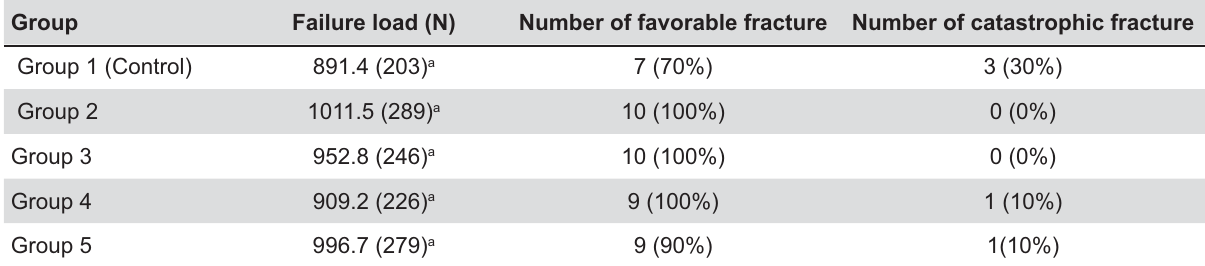
(cid:2)(cid:3)(cid:4)(cid:3)(cid:5)(cid:6)(cid:7)(cid:8)(cid:9)(cid:10)(cid:11)(cid:12)(cid:7)(cid:9)(cid:13)(cid:7)(cid:3)(cid:11)(cid:14)(cid:8)(cid:5)(cid:12)(cid:14)(cid:14)(cid:12)(cid:7)(cid:8)(cid:3)(cid:15)(cid:16)(cid:3)(cid:13)(cid:6)(cid:14)(cid:12)(cid:9)(cid:8)(cid:15)(cid:17)(cid:8)(cid:9)(cid:3)(cid:18)(cid:15)(cid:3)(cid:19)(cid:13)(cid:6)(cid:15)(cid:14)(cid:8)(cid:16)(cid:3)(cid:20)(cid:20)(cid:12)(cid:7)(cid:12)(cid:15)(cid:13)(cid:12)(cid:8)(cid:21)(cid:12)(cid:14)(cid:22)(cid:12)(cid:12)(cid:15)(cid:8)(cid:16)(cid:3)(cid:20)(cid:20)(cid:12)(cid:7)(cid:12)(cid:15)(cid:14)(cid:8)(cid:14)(cid:12)(cid:9)(cid:14)(cid:8)(cid:18)(cid:7)(cid:17)(cid:10)(cid:11)(cid:9)